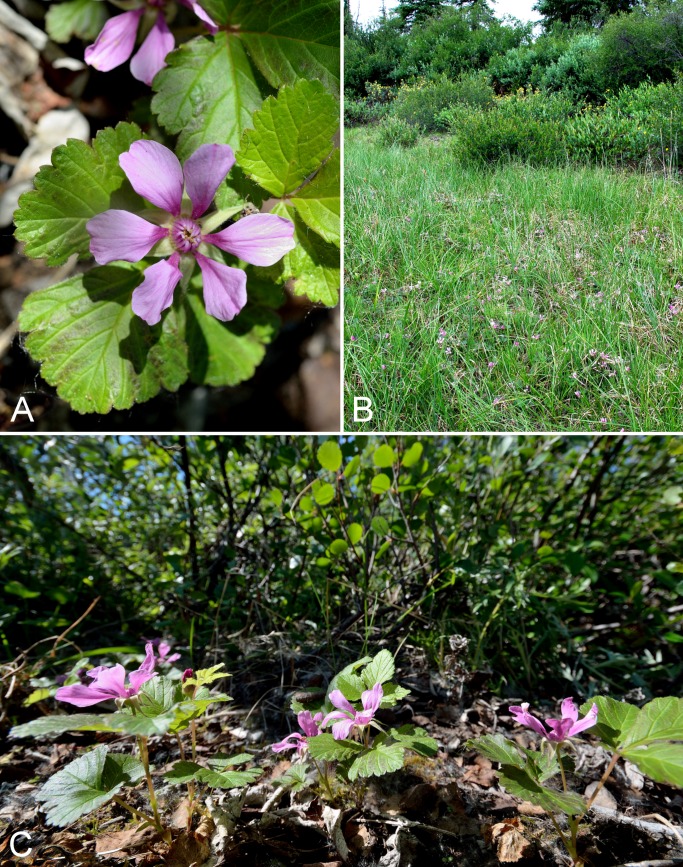
Rubus arcticus subsp. acaulis.(A) Inflorescence, Saarela et al. 3190. (B) Habitat, Saarela et al. 3190. (C) Habit, Saarela et al. 3190. Photographs by R. D. Bull (A, C) and J. M. Saarela (B).